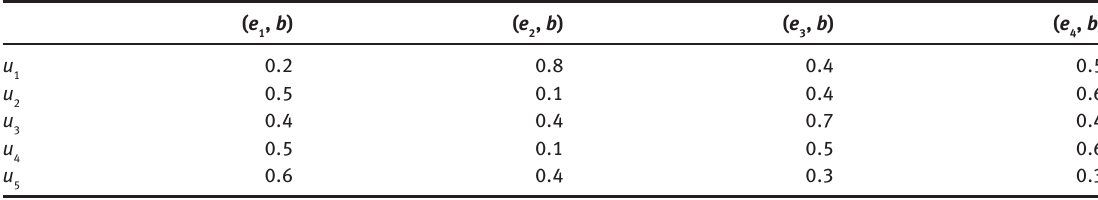
Table 2: Opinions of Expert b .